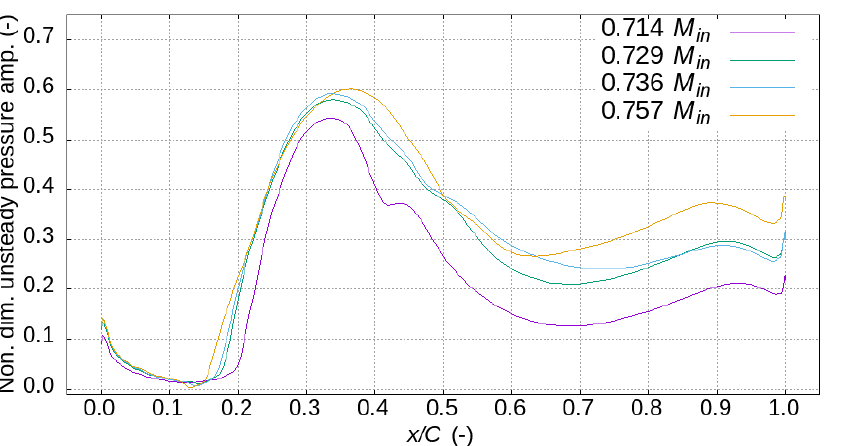
Figure 15. Profiles of Fourier-decomposed unsteady pressure amplitudes on the OGV suction surface for varying M in .